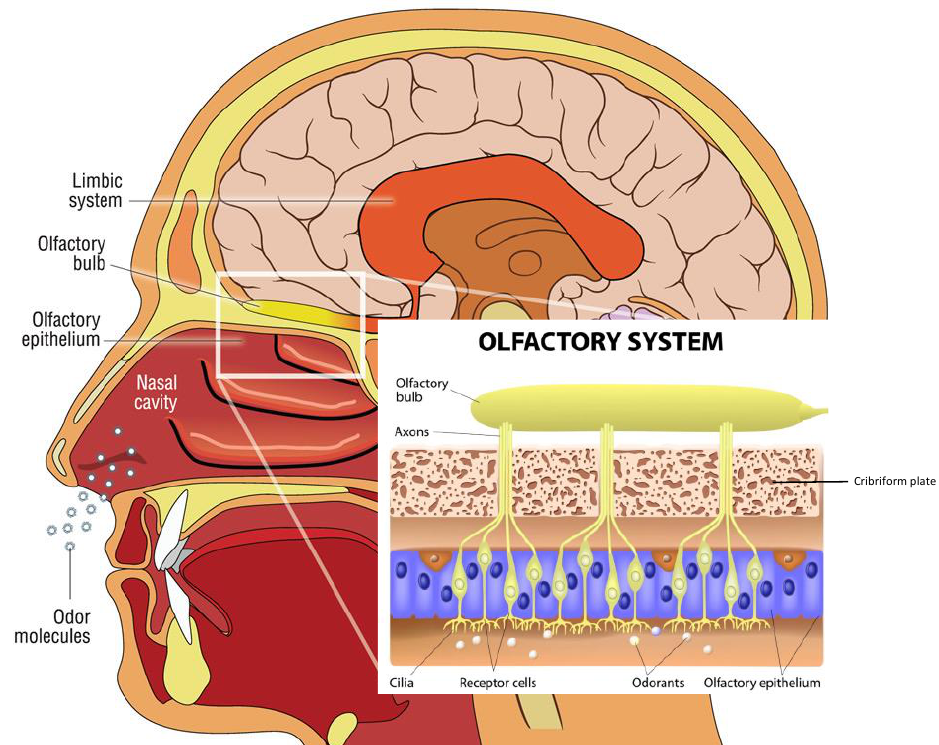
Figure 2. Descriptive anatomy of odorant signal transmission and the human olfactory system. In the box, a focus is on the olfactory system, with neuroepithelium, composed of olfactory sensory neurons that, through the lamina cribrosa plate, establish a synaptic connection with the mitral cells of the olfactory bulb. The axons of the monosynaptic mitral cells that make up the olfactory tract bifurcate at the terminus, fornix, or olfactory cortices. Primarily, the limbic system with the pyriform cortex, amygdala, and entorhinal cortex is involved. (Modified from medical illustration by Patrick J. Lynch).